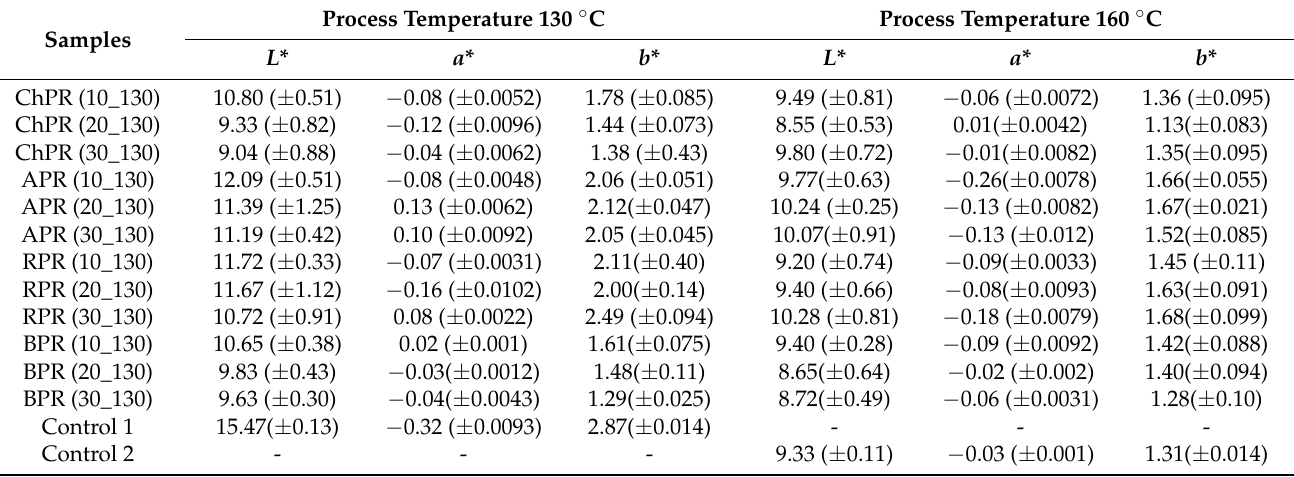
Figure 5. Average colour change values, ∆ E , resulting from increase in process temperature from 130 to 160 ◦ C. Table 3. Average values of L*, a*, b* colour changes for all biocomposites with each share of used additives. Average of five repetitions.